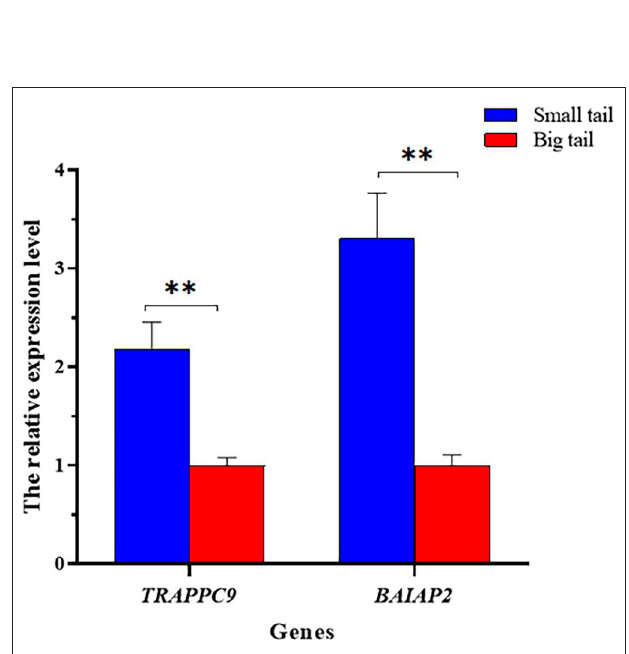
FIGURE 5 | The relative TRAPPC9 and BAIAP2 mRNA expression levels between the small-tail and big-tail groups. Asterisks indicate a significant differences between the small- and big-tail groups ( P < 0.05), double asterisks indicate a very significant differences between the small-tail and big-tail groups ( P <